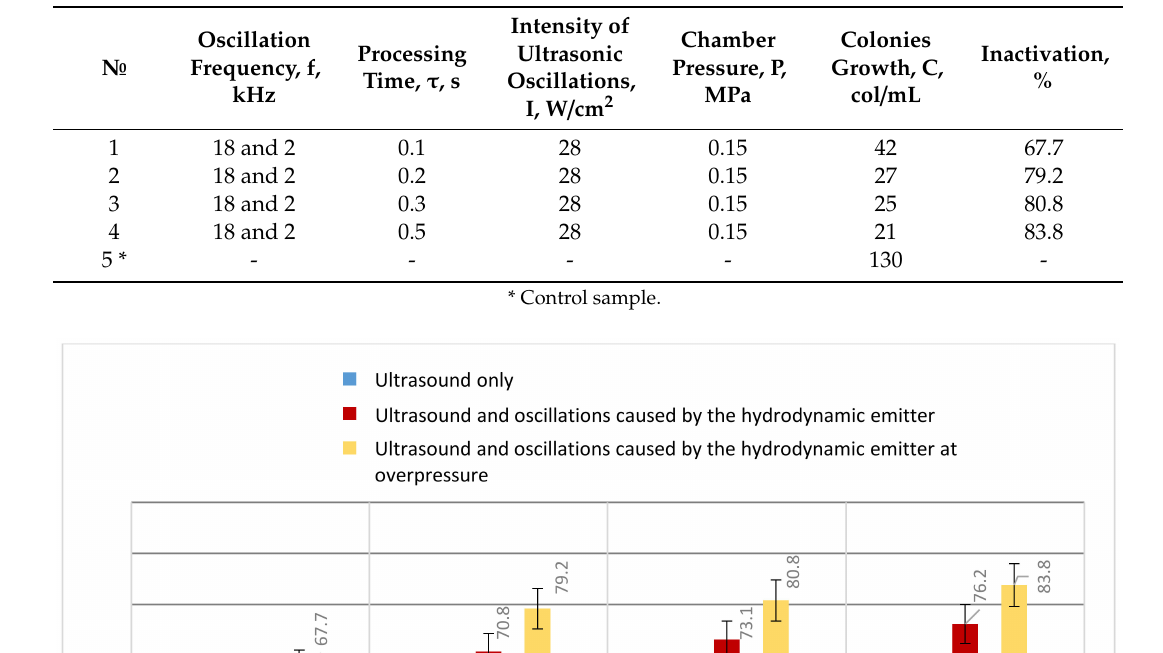
Table 3. Results of experimental studies of the e ff ect of the combination of ultrasonic treatment and treatment by a hydrodynamic emitter on microorganism inactivation (at overpressure).